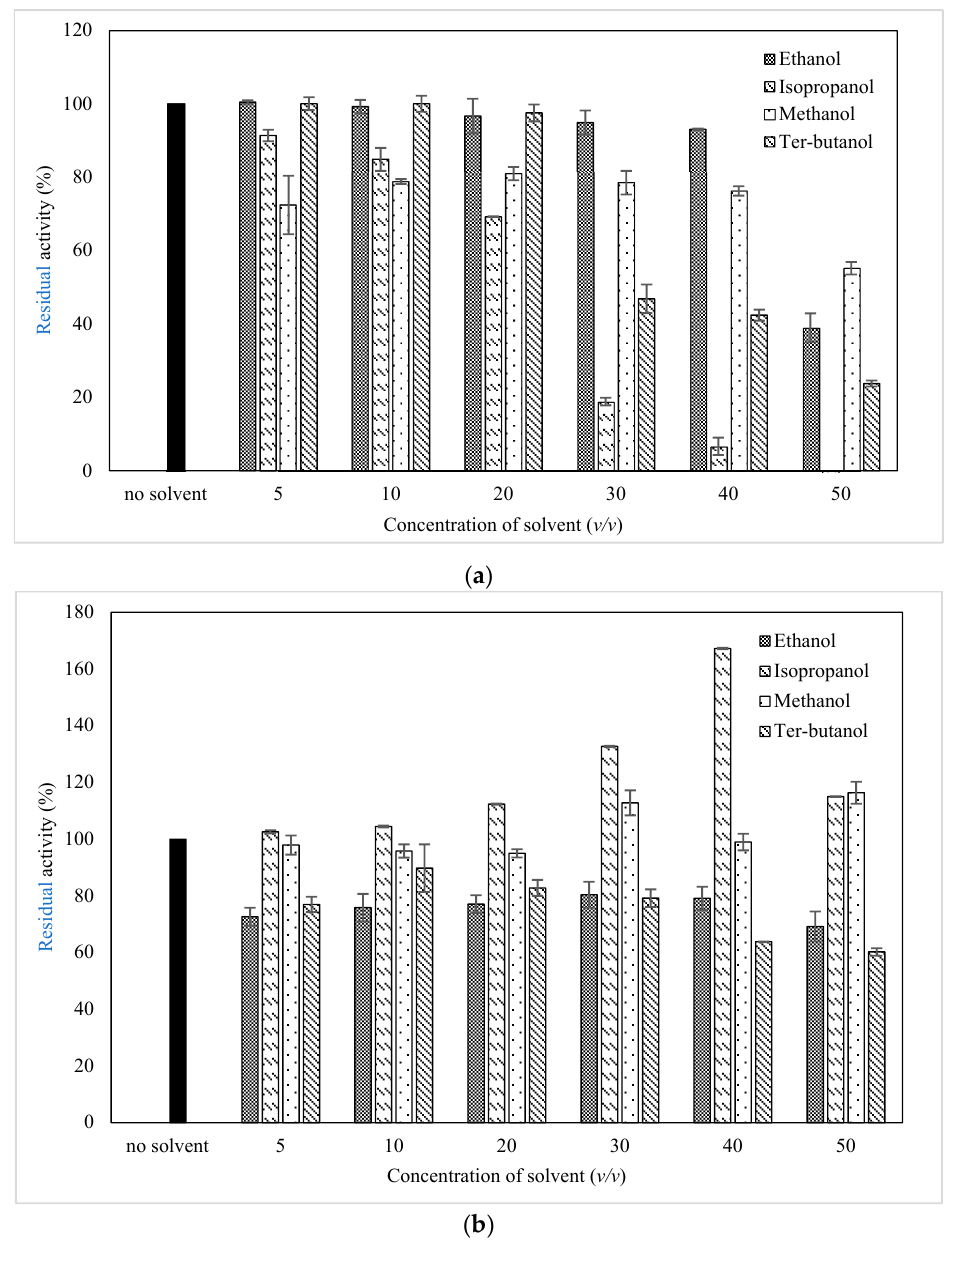
Figure 9. Solvent tolerance analysis of ( a ) free CRL and ( b ) CRL/MgO-Al 2 O 3 at 5, 10, 20, 30, 40, and 50% ( v / v ) of solvent concentration . The 100% of residual activity for CRL and CRL/MgO-Al 2 O 3 indicated as the initial lipase activity without solvent addition.